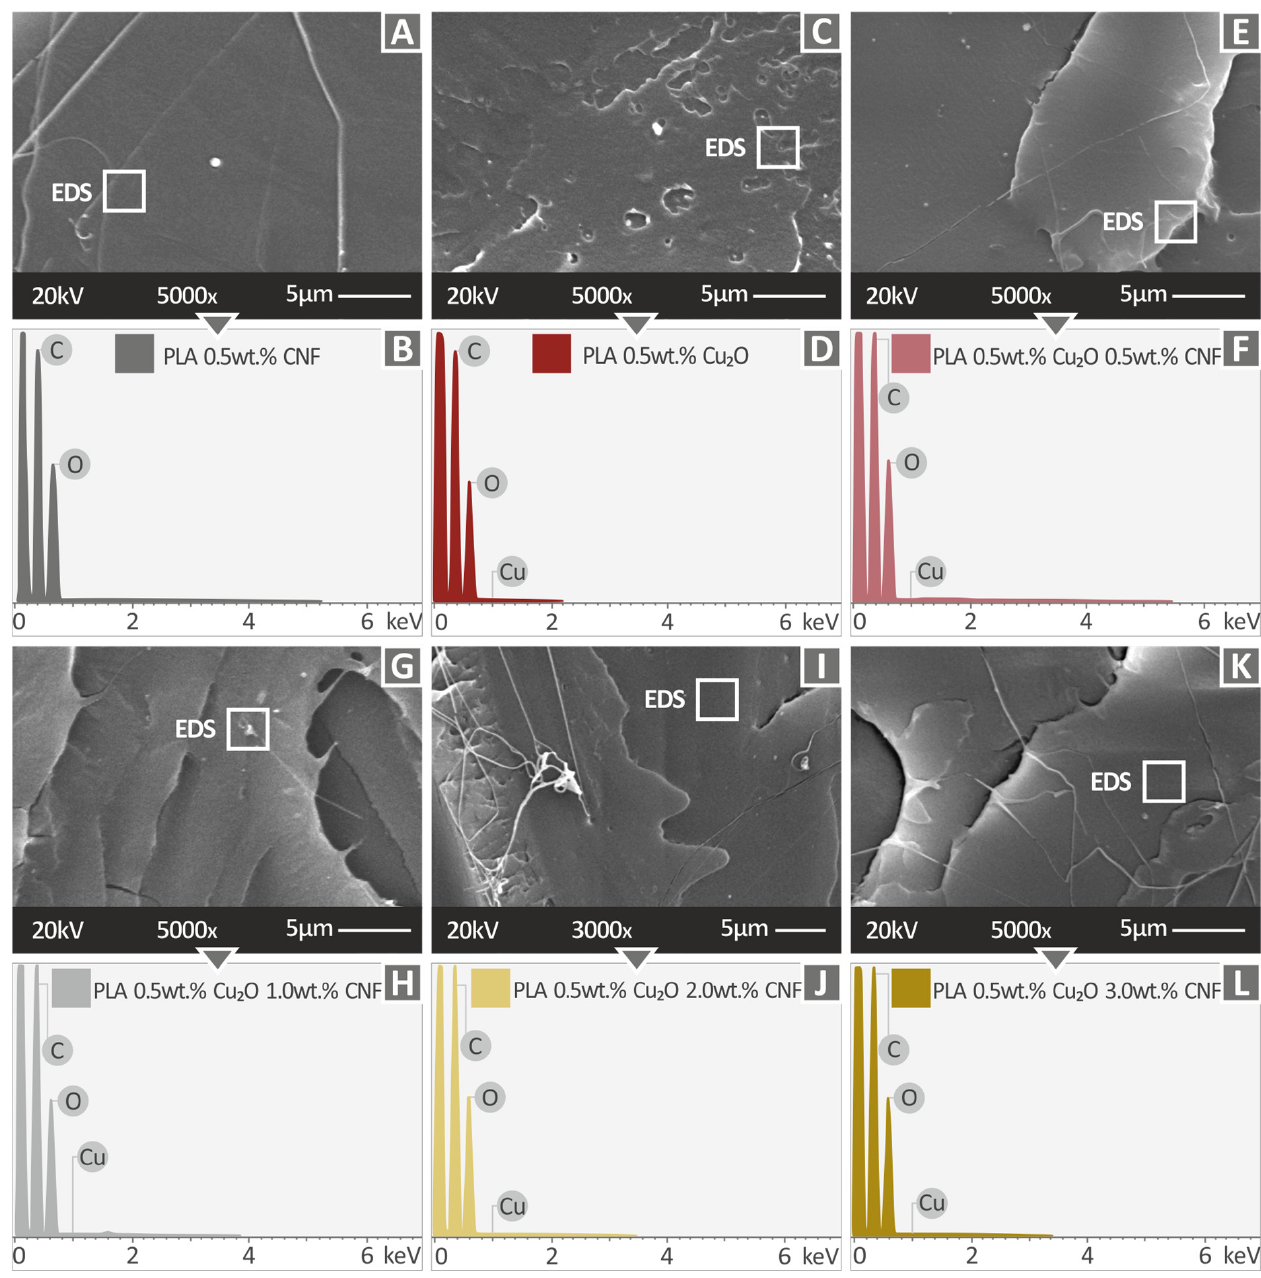
Figure 14. SEM images at 5000× magnification and the corresponding EDS graphs for PLA with: ( A , B ) 0.5 wt.% CNF, ( C , D ) 0.5 wt.% Cu 2 O, ( E , F ) 0.5 wt.% Cu 2 O 0.5 wt.% CNF, ( G , H ), 0.5 wt.% Cu 2 O 1.0 wt.% CNF, ( I , J ) 0.5 wt.% Cu 2 O 2.0 wt.% CNF, and ( K , L ) 0.5 wt.% Cu 2 O 3.0 wt.% CNF.